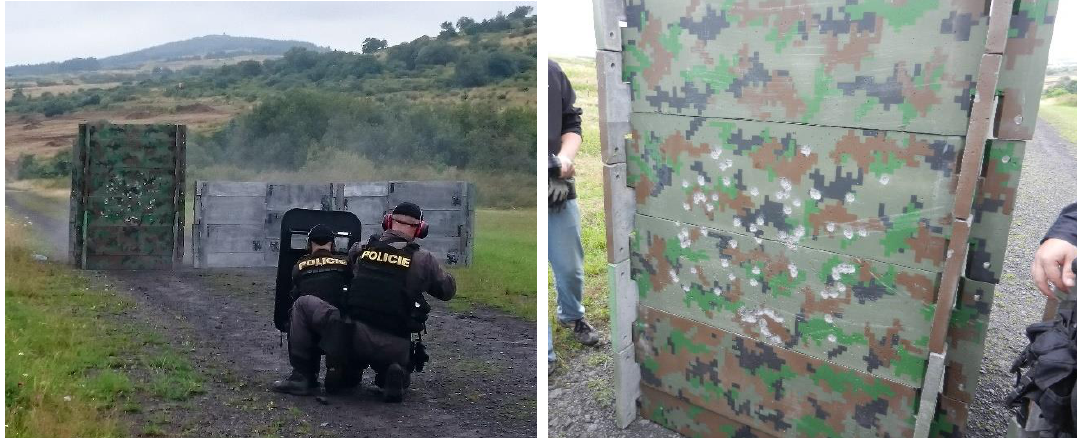
Figure 20. Ballistics loading of the tetragon house (on the left) and the post-test picture showing surface erosion from individual hits on the proximal face of the UHPFRCC plates (on the right).